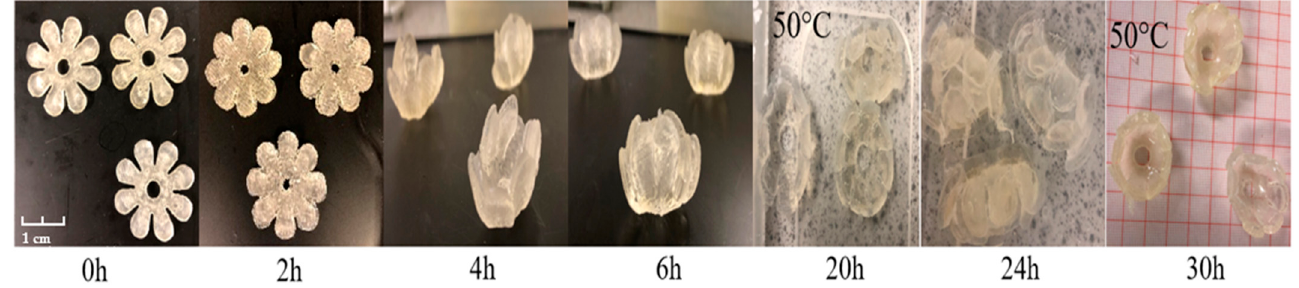
Figure 10. The appearance of swollen bilayer fl ower samples at time: 0 h, 2 h, 4 h, 6 h, 20 h (50 °C), 24 h and 30 h (50 °C).